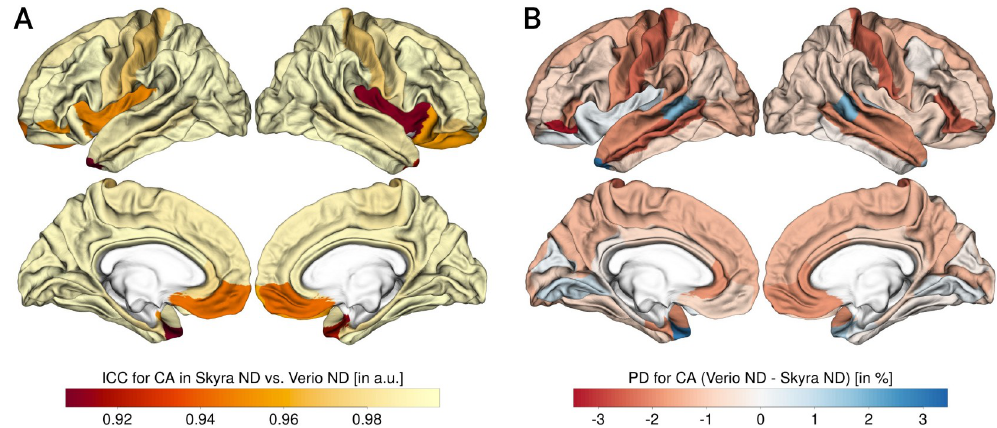
Fig 3. Reliability and percent differences for cortical area (CA). A: CA ICC, B: CA PD (for each panel, left column shows lateral and medial view of left hemisphere, right column shows lateral and medial view of right hemisphere), negative values: Skyra > Verio, positive values: Verio >